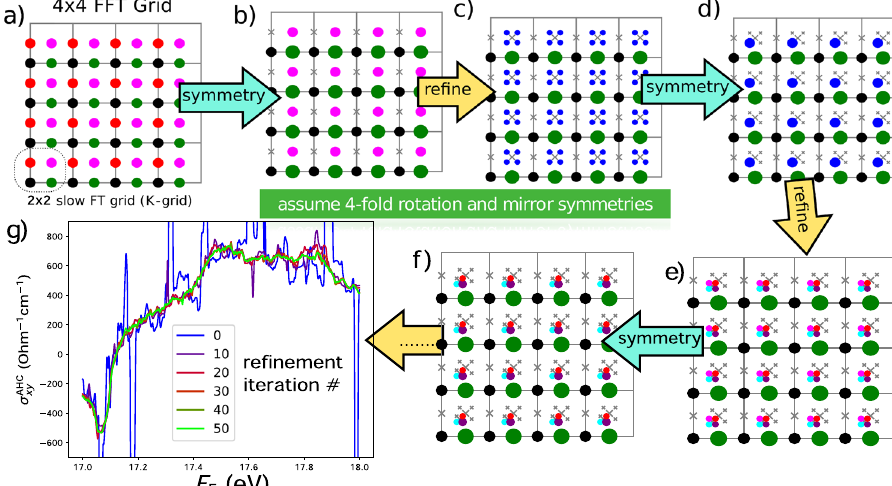
Fig. 1 Illustration of the procedure of mixed Fourier transform, adaptive re fi nement, and use of symmetries. a – f show the procedure step by step using a 2D picture for visualization purposes, while the code actually works in 3D. The area of colored circles corresponds to the weight of the K point, gray crosses denote the points with zero weight. See the text for a detailed description. g AHC of bcc Fe, evaluated from a grid of 50 × 50 × 50 k points and 50 recursive adaptive re fi nement